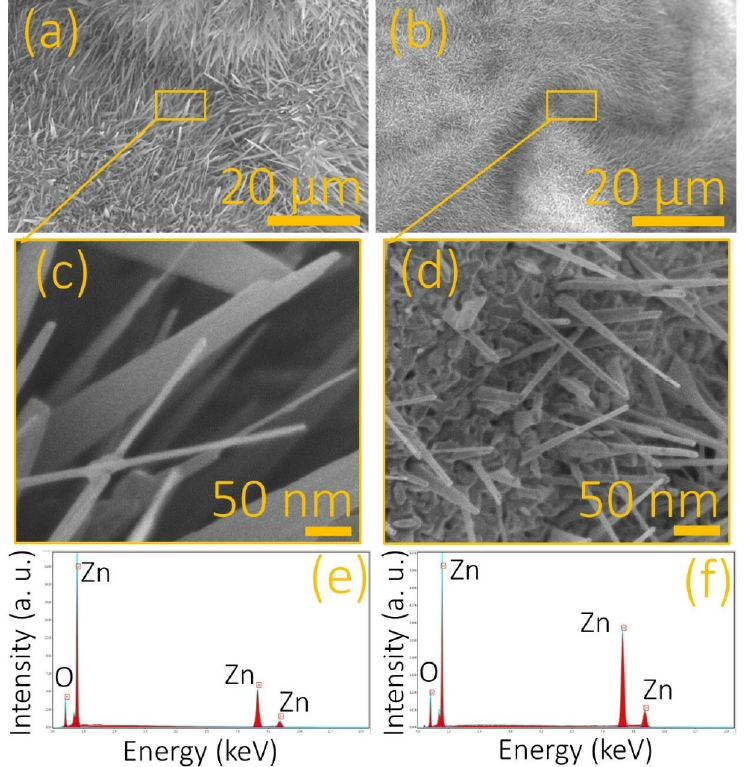
Figure 2. Zn foils etched with HNO 3 at ( a ) 2 M and ( b ) 8 M imaged by FESEM after the TO pro ‐ cessing. ( c , d ) Close views of the samples in ( a , b ), respectively. Recorded EDS spectra from the ( e ) ZnO grass ‐ like and ( f ) ZnO cane ‐ like nanostructures.